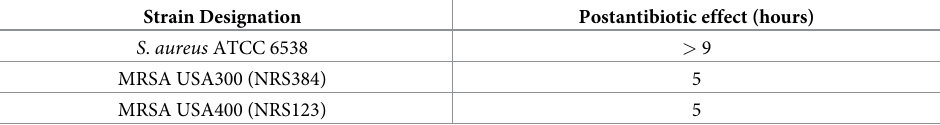
Table 1. Postantibiotic effect of ebselen (tested at 5 × MIC) against three different strains of Staphylococcus aureus .